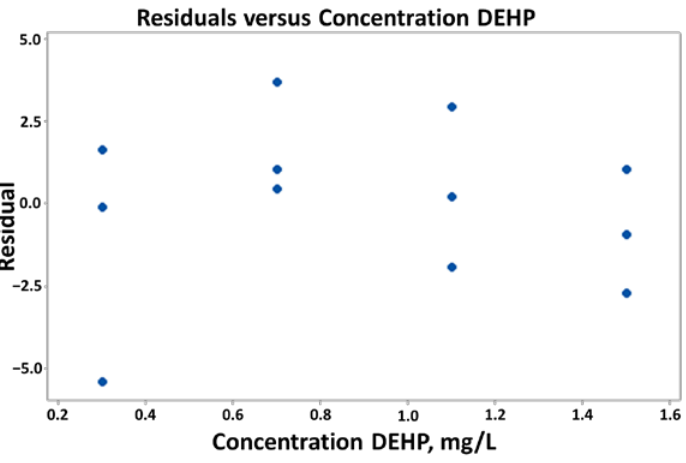
Figure 6. Plot of residuals in terms of DEHP concentration, to check for linearity. Sensitivity plot: